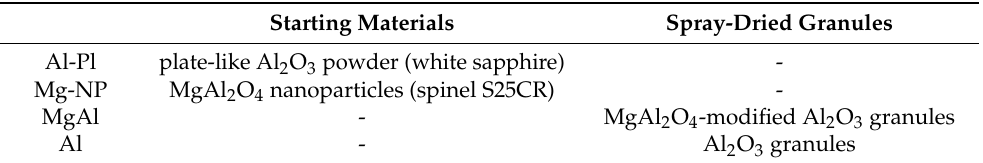
Table 1. Material nomenclature. Starting Materials Spray-Dried Granules Al-Pl plate-like Al 2 O 3 powder (white